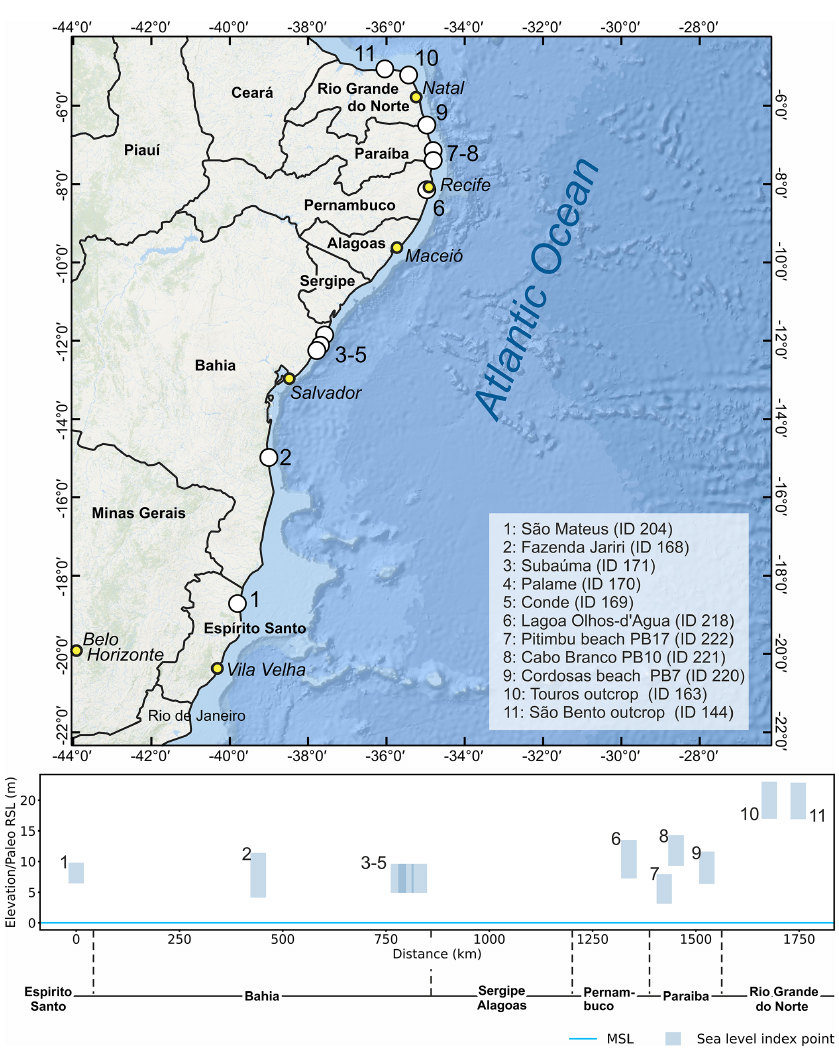
Figure 4. Last interglacial sea-level data in the Brazilian states of Espírito Santo, Bahia, Pernambuco, Paraíba, and Rio Grande do Norte. Upper panel: map of sites. Basemap: Esri, Garmin, GEBCO, NOAA NGDC (now NCEI), and other contributors. Lower panel: distance– elevation